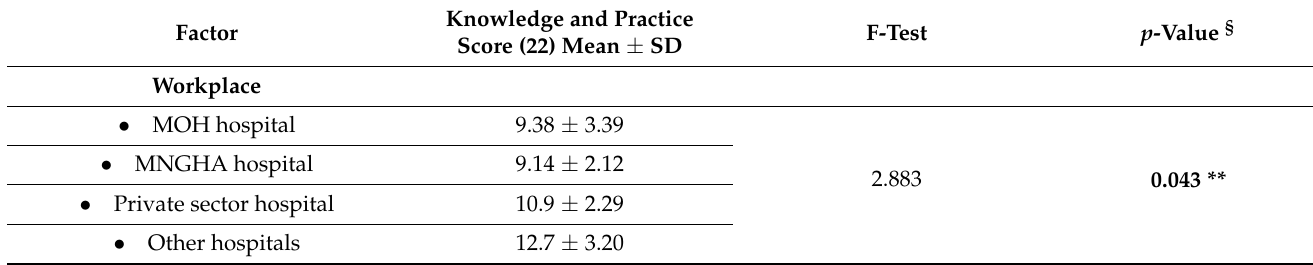
Table 4. Differences in the overall score of knowledge and practice according to workplace and years of